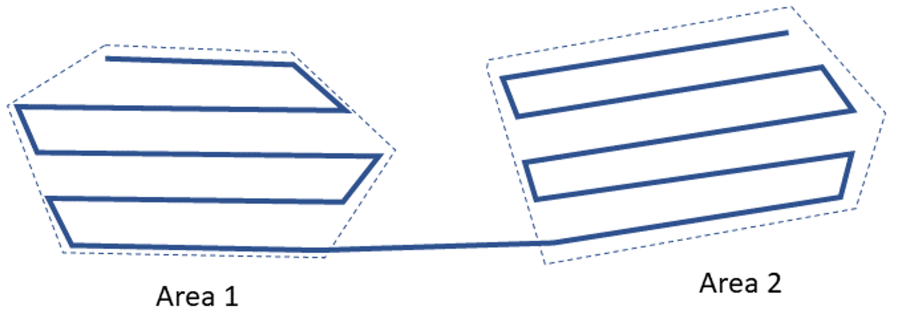
Figure 6. Schema of area joining